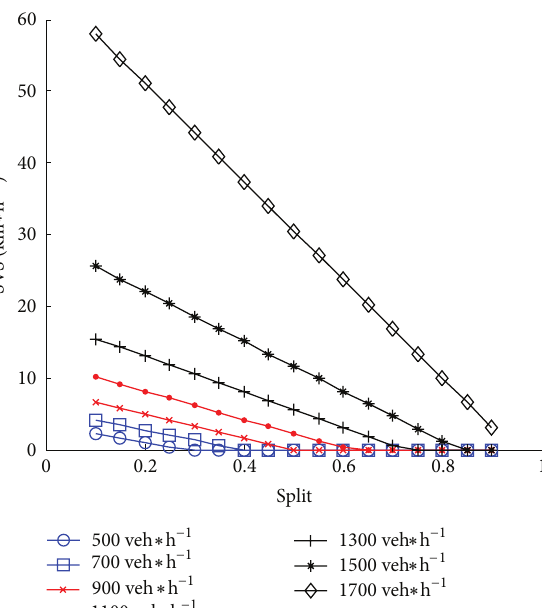
Figure 12: Virtual split propagation, 𝐶 = 100 s, 𝑔 = 40 s, 𝑟 = 50 s, = 180 veh/km, 𝑞 = 1800 veh/h. 𝑞 = 1000 ve/h, 𝑘 𝑗 𝑚